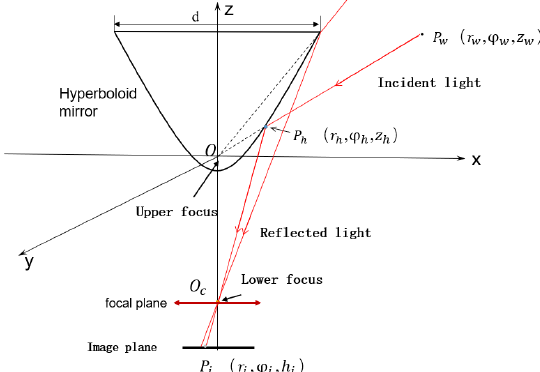
Figure 1. Cylindrical coordinate systems and imaging optical path of hyperboloid panoramic vision systems.